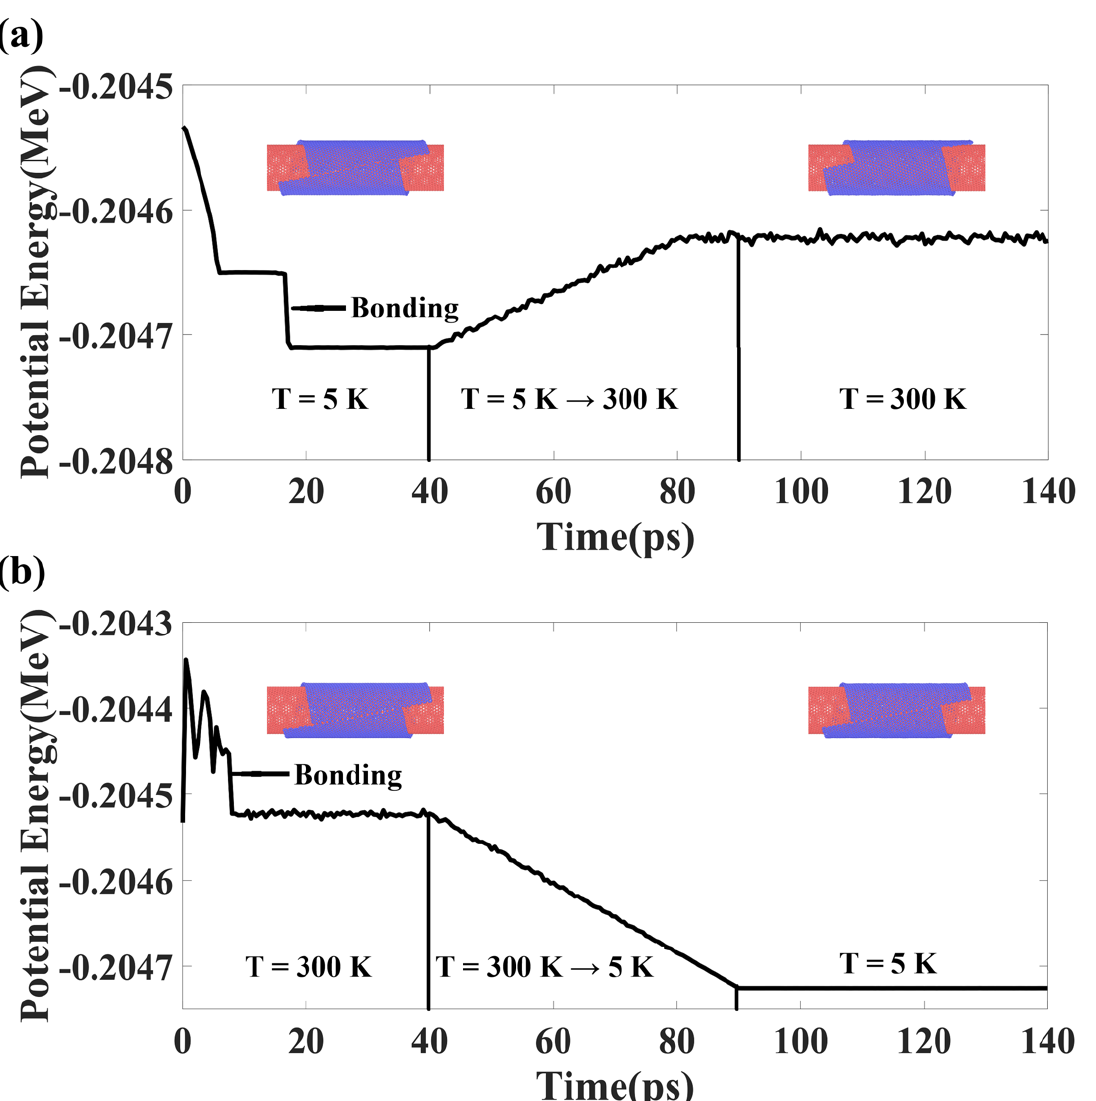
Figure 5. Influence of temperature environment on the dynamics of the self-assembled structure. ( a , b ) Two difference thermal schemes are adopted to the assemble process, both yield the same eventual configuration, which is found to be stable without plastic phase transformation. The (44,6) SWCNT and a GNR of 13.4 × 10.0 nm 2 are used in this study.